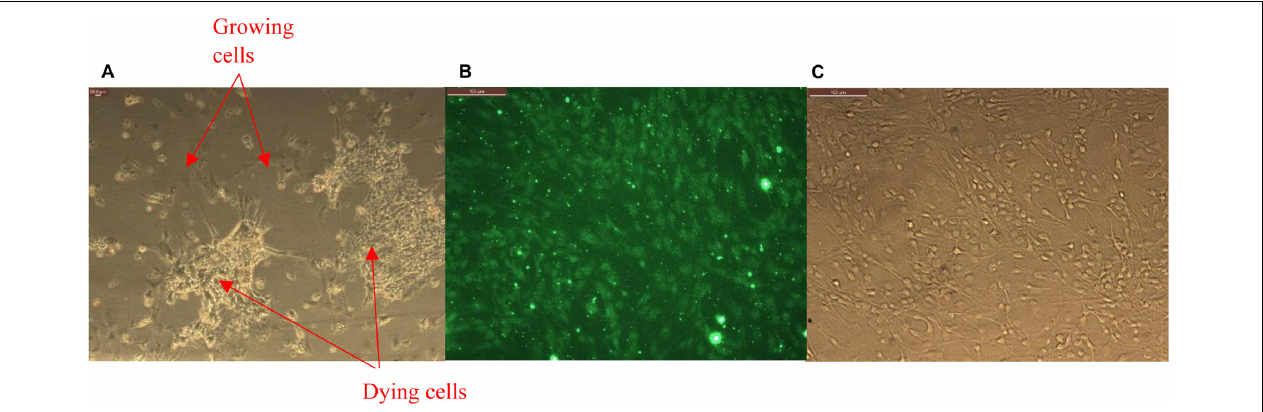
FIGURE 2 | (A) Primary glia treated with puromycin for isolation of brain microvascular endothelial cells (BMVECs) showing killing of all other cell types except the BMVECs. (B) Primary BMVECs characterized by staining against VWF using fluorescence microscopy, and (C) phase image of stained